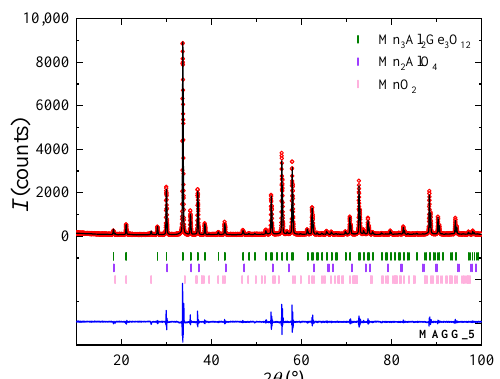
Figure 3. PXRD profile of a Mn 3 Al 2 Ge 3 O 12 polycrystalline sample (sample labeled MAGG_5), prepared in three steps, at 900 ◦ C, 1100 ◦ C, and 1150 ◦ C for 24 h. The red open circles represent the experimental profile and the black line is the calculated profile, with the difference given by the blue line. The reflections of the Mn 3 Al 2 Ge 3 O 12 garnet structure are indicated by green “ (cid:120) ” while orthorhombic ( Pbca ) MnO 2 and cubic ( Fd ¯3 m ) Mn 2 AlO 4 are represented by the pale pink and purple “ (cid:120) ”